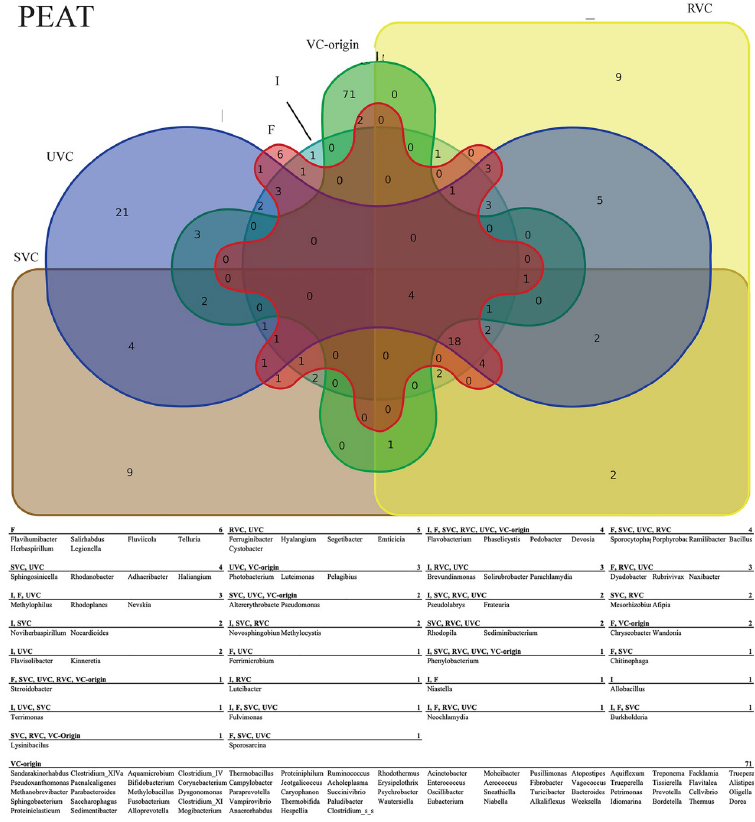
Fig 2. Peat rhizosphere taxa diagram. Venn diagram of observed genera across all treatments in peat. The associated table lists genera corresponding to treatment-specific and shared taxa.